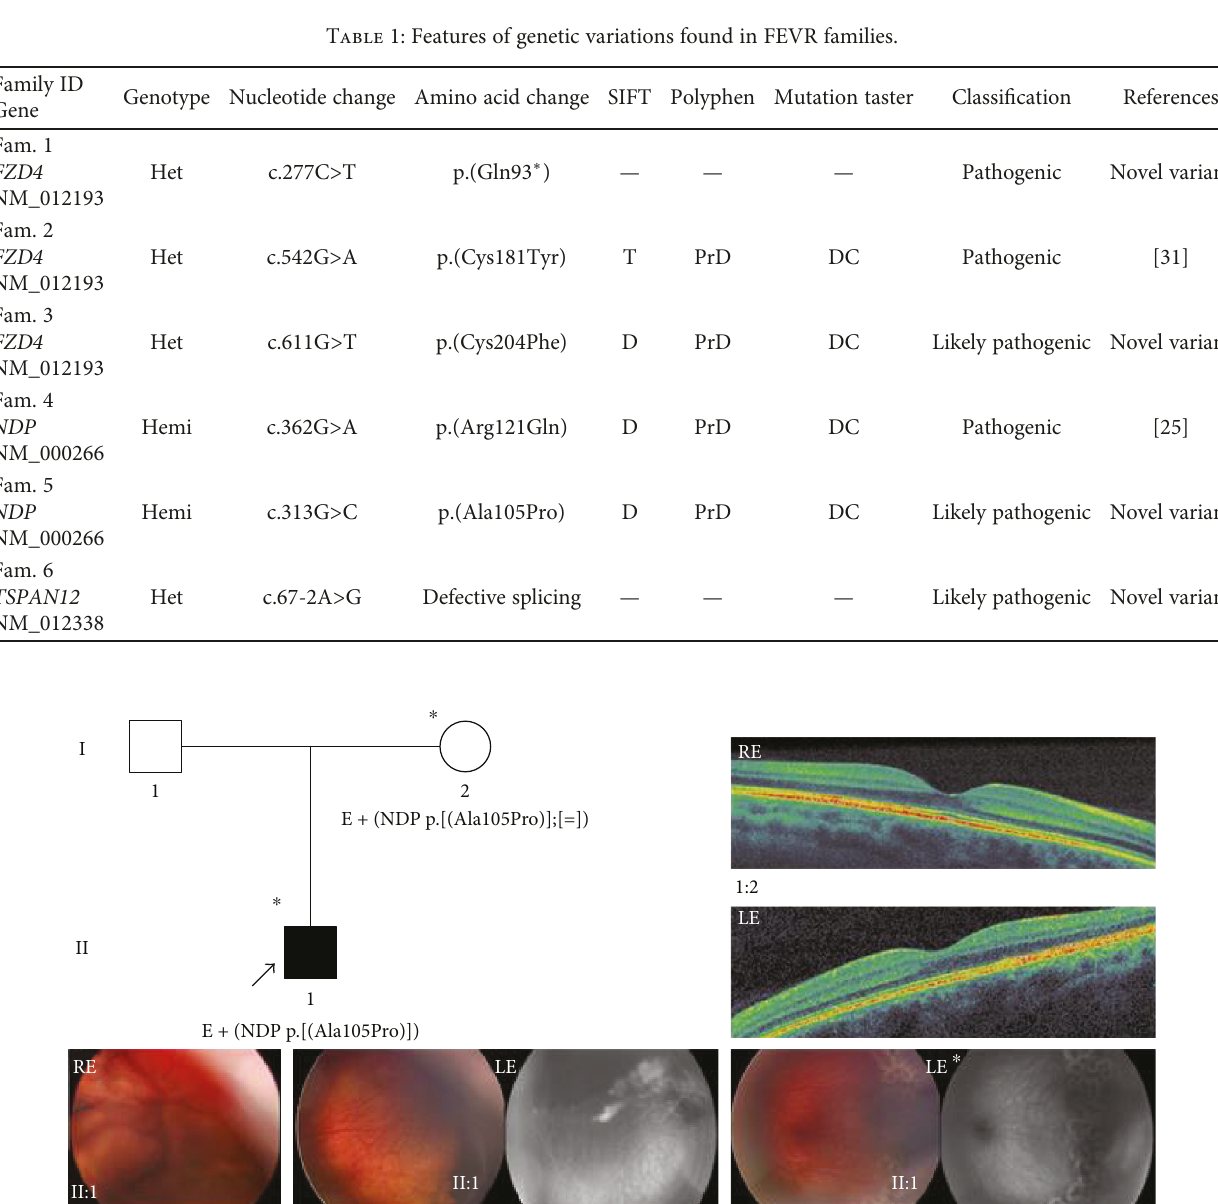
Figure 5: Pedigree and ocular features of family 5. Color fundus photographs by RetCam from the 3 y/o male proband (II:1) of family 5 showing a closed funnel total retinal detachment in the right eye and peripheral exudation with vascular abnormalities before and after laser treatment in the left eye. Fluorescein angiograms performed with RetCam before and after laser treatment showing peripheral ischemic areas with leakage mainly in temporal and inferior peripheral retina in the left eye. Top right, OCT macular scans from the proband ’ s mother (I:2) showing normal retinal features. ∗ Documented clinical evaluation; E+, positive to genetic test; RE, right eye; LE, left eye; LE ∗ , images taken at a subsequent examination after the laser